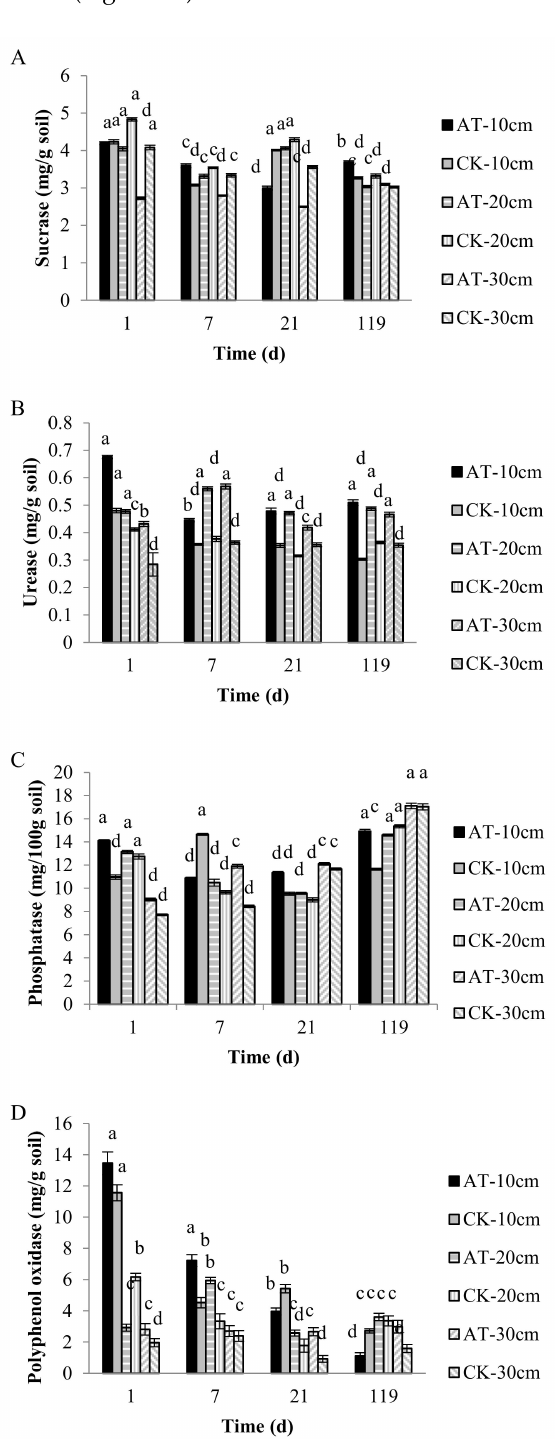
Figure 2. Effect of atrazine on enzyme activity in cultivated soil layers in different periods in chernozem of cold region. ( A ) Sucrase, ( B ) urease, ( C ) phosphatase, ( D ) polyphenol oxidase. Each value represents mean ± SD ( n = 3). There is no significant difference between CK and AT groups ( p > 0.05), but there is a significant difference between CK and AT groups ( p < 0.05). Where a, b, c, d means that there is no significant difference with the same letter, and there is significant difference with different